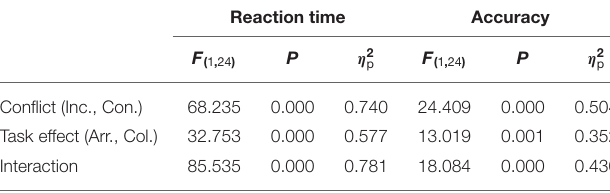
TABLE 2 | Two-Factor ANOVA of repeated measures of behavioral data ( N = 25). Reaction time